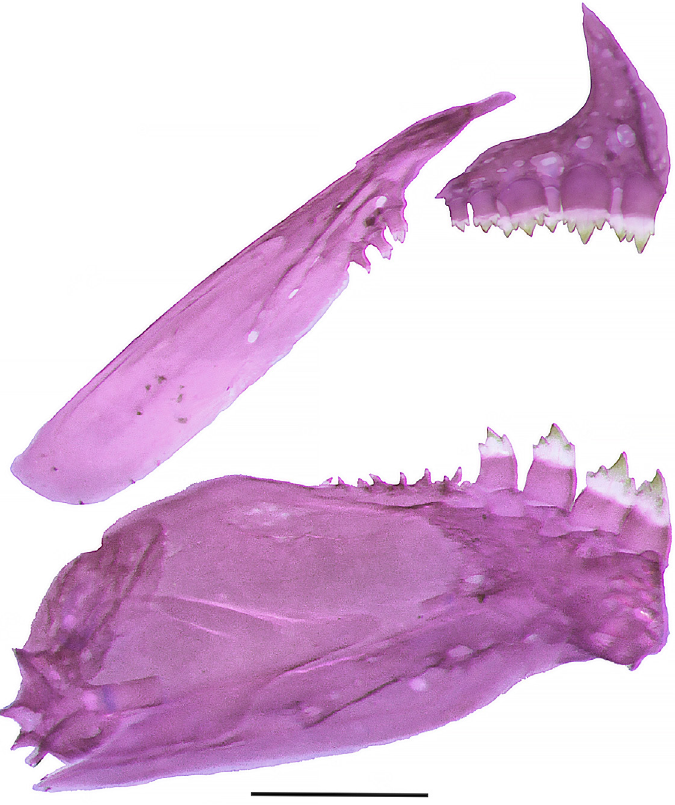
FIGURE 2 | Medial view of left side, premaxillary, maxillary, and dentary of Moenkhausia cambacica , MZUSP 125793, 27.1 mm SL, paratype. Scale bar: 1